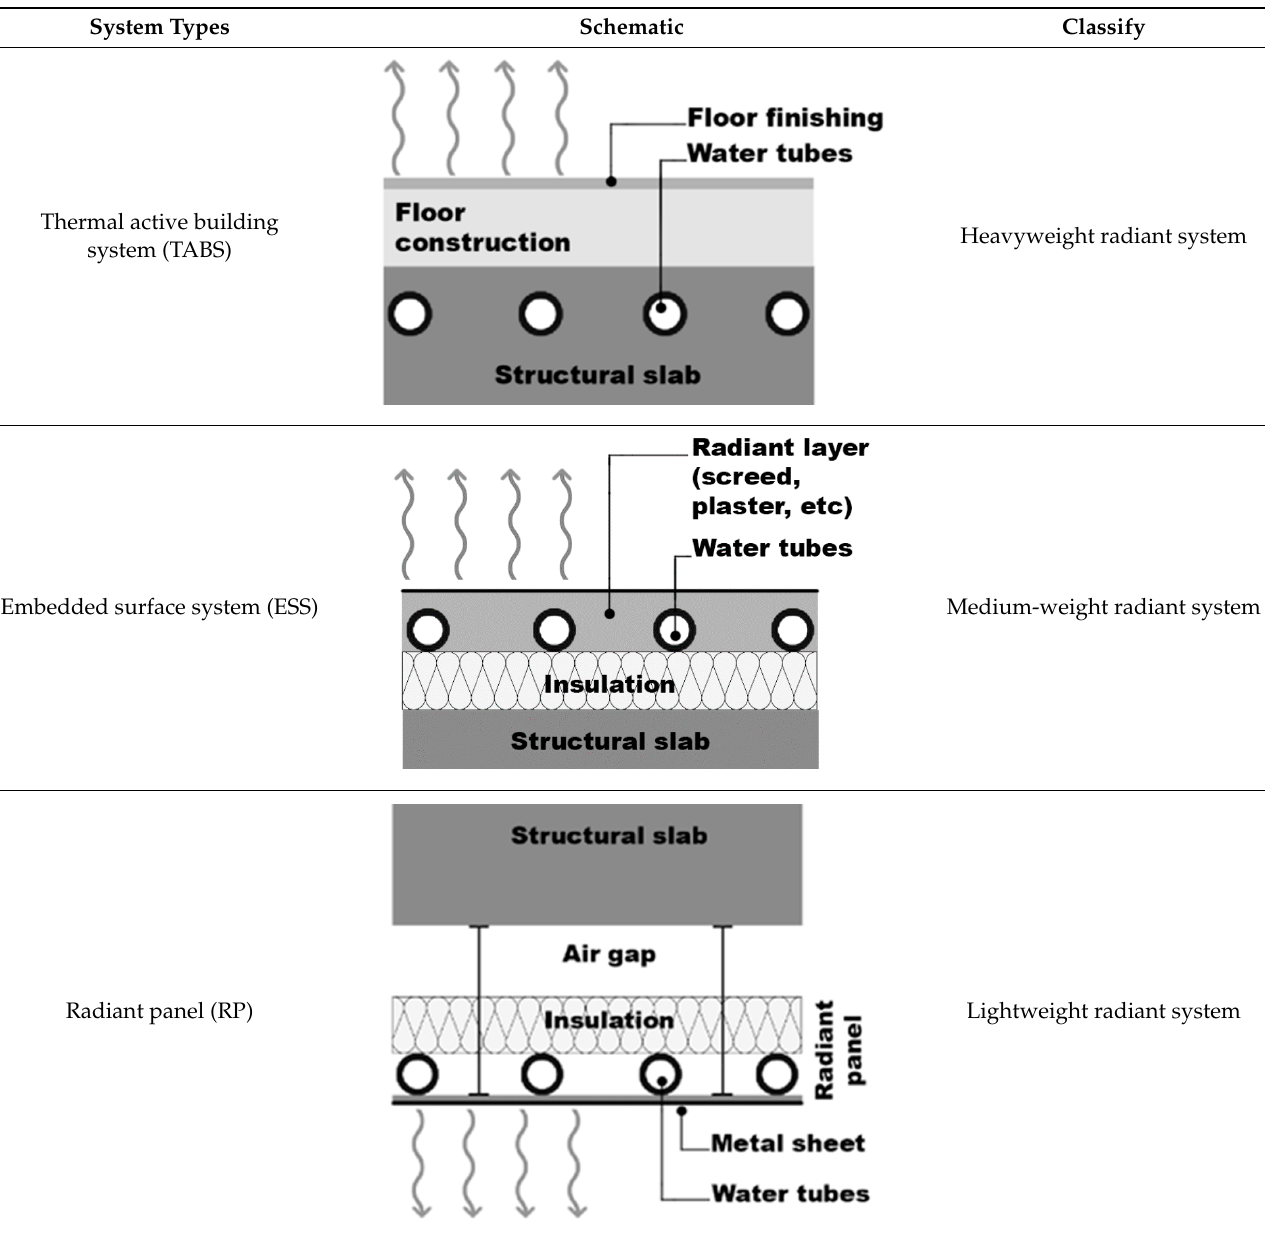
Table 1. Types of hydronic radiant systems [11]. Source: Redrawn by the first author.